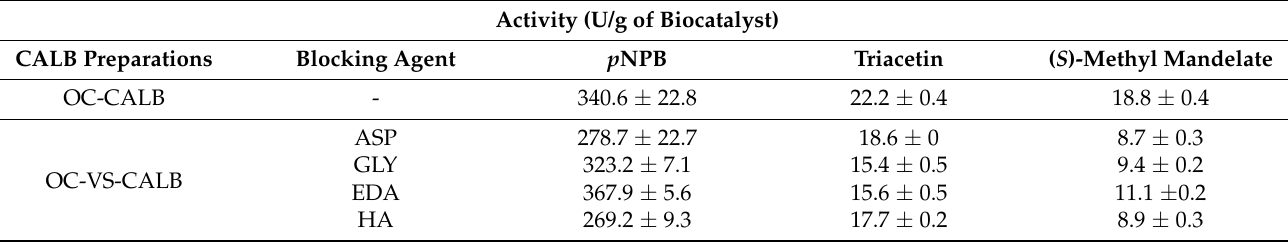
Table 3. Mass activity (U/g) of different immobilized CALB biocatalysts with 50 mM ( S )-methyl mandelate (pH 7.0, 25 ◦ C), 50 mM of triacetin (pH 5.0, 25 ◦ C) or 1 mM of p NPB (pH 7.0, 25 ◦ C). Experiments were performed as described in